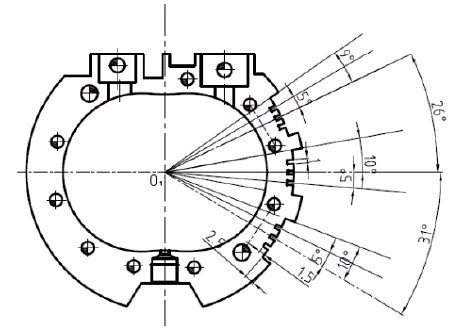
Figure 14. Designed microtextures on cylinder outer surface.